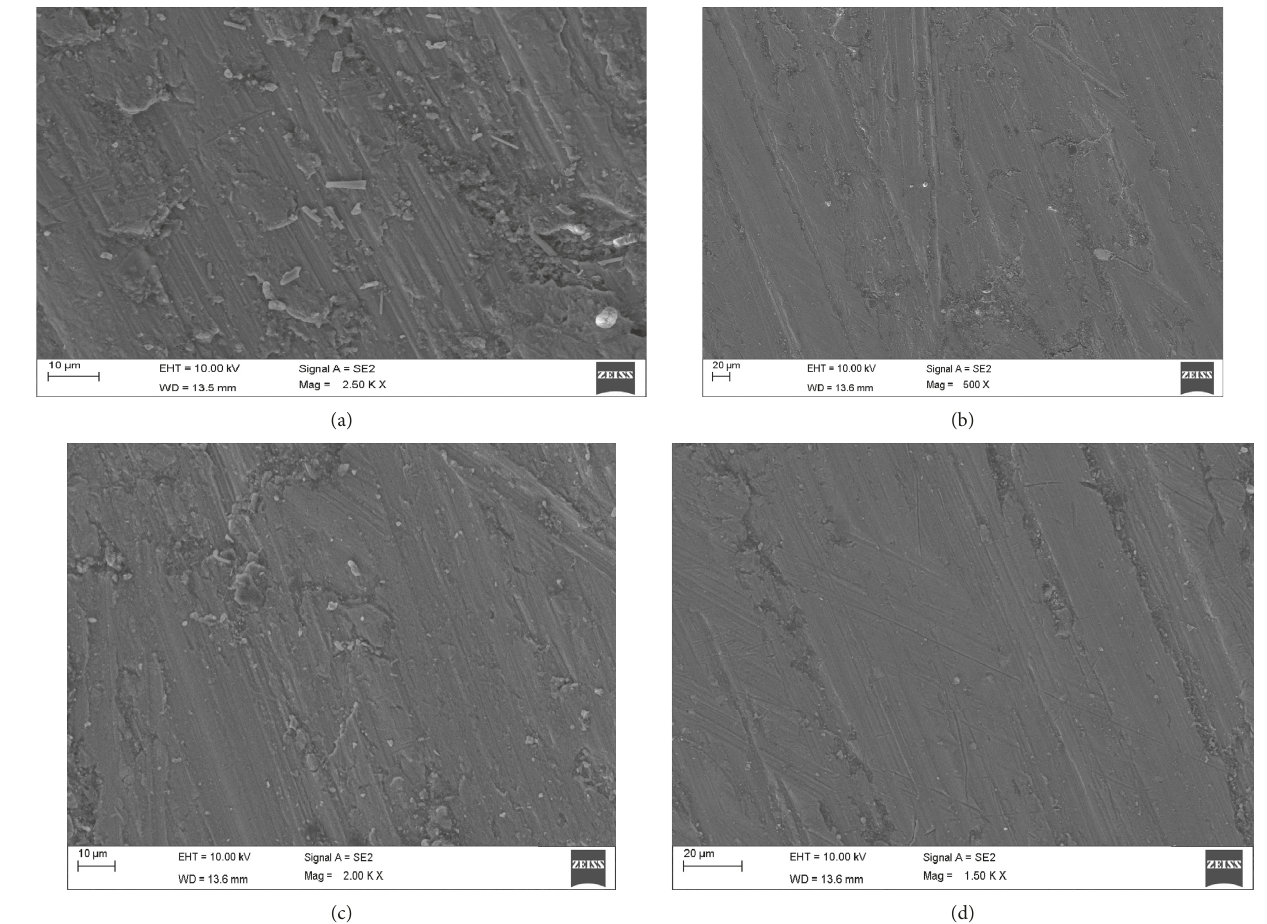
Figure 9: SEM analysis for 4% of reinforcement Al composite without glass fibre.